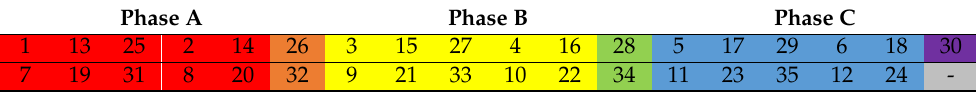
Figure 2. Slot distribution to phases of M 3 .